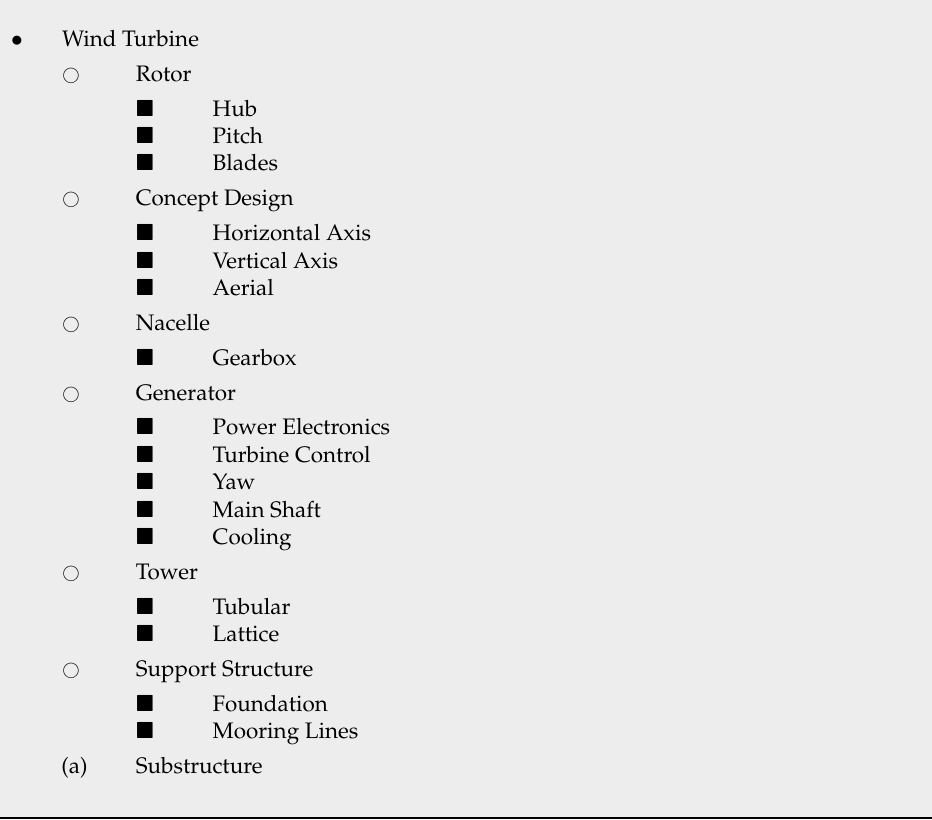
Table 13. Hierarchy for Wind turbine-related topics in the Production of Electricity from Wind